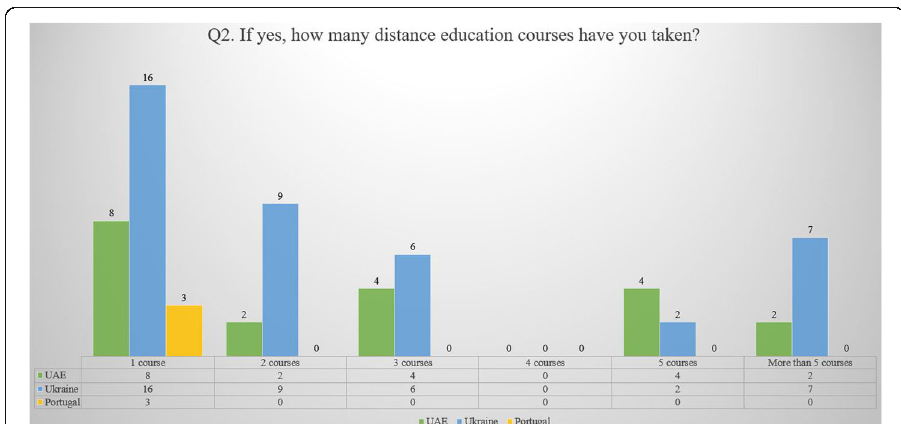
Fig. 2 Number of distance education courses